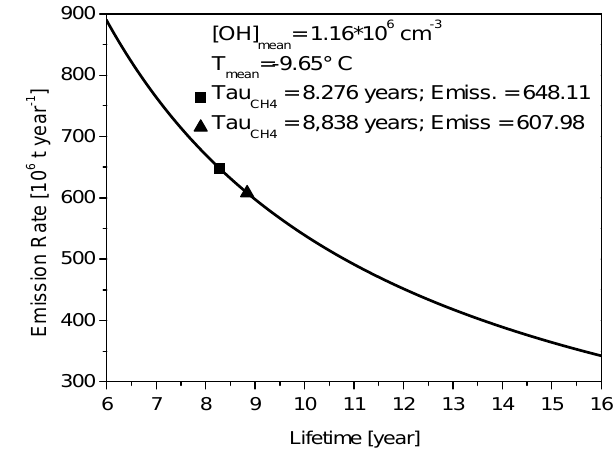
Fig. 1. Global methane emission rate versus lifetime of methane for a current atmospheric methane concentration of 1.8ppmv. This in- cludes an annual growth rate of methane of 5ppbva − 1 correspond- ing to an increasing emission of 1.457Mta − 1 . The lifetime depends inversely on the mean OH concentration and the tropospheric tem-